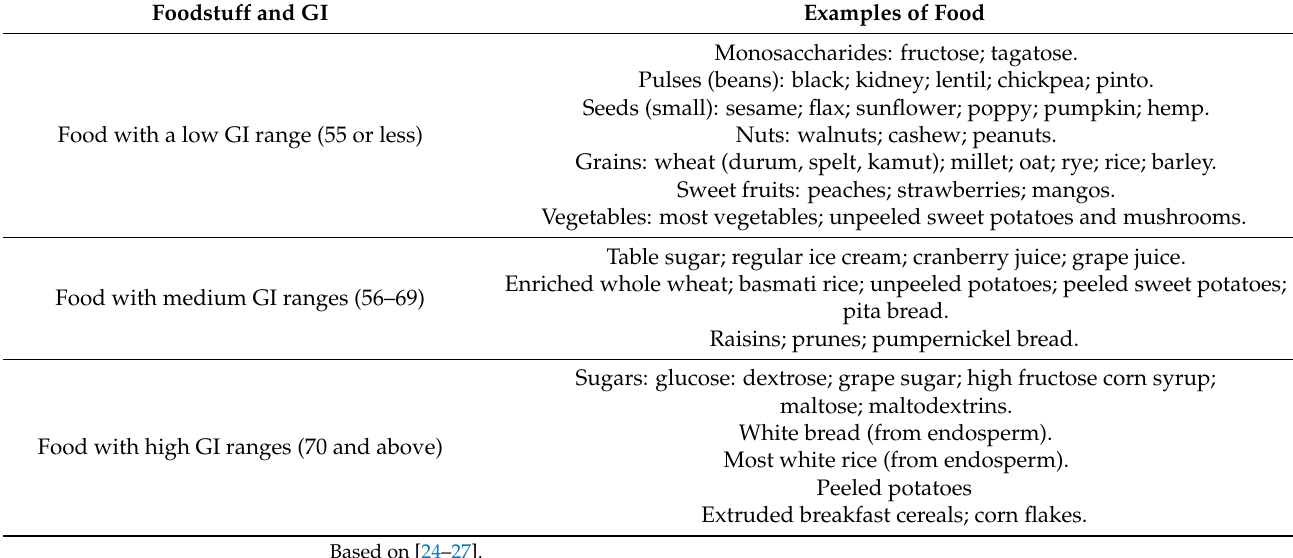
Food with a low GI range (55 or less) Food with high GI ranges (70 and above)